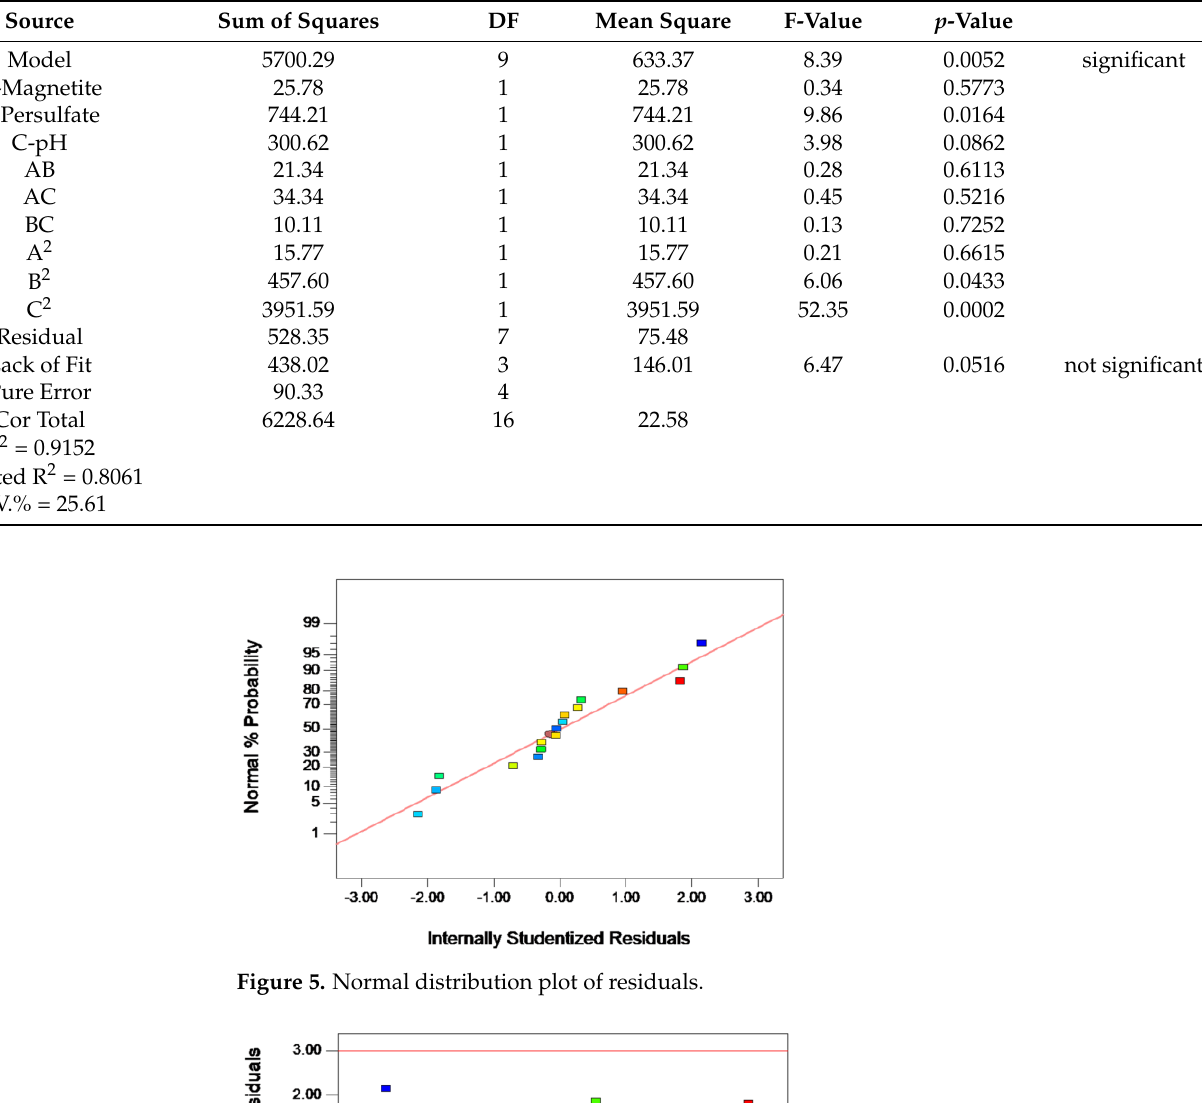
Table 4. ANOVA and test of significance.